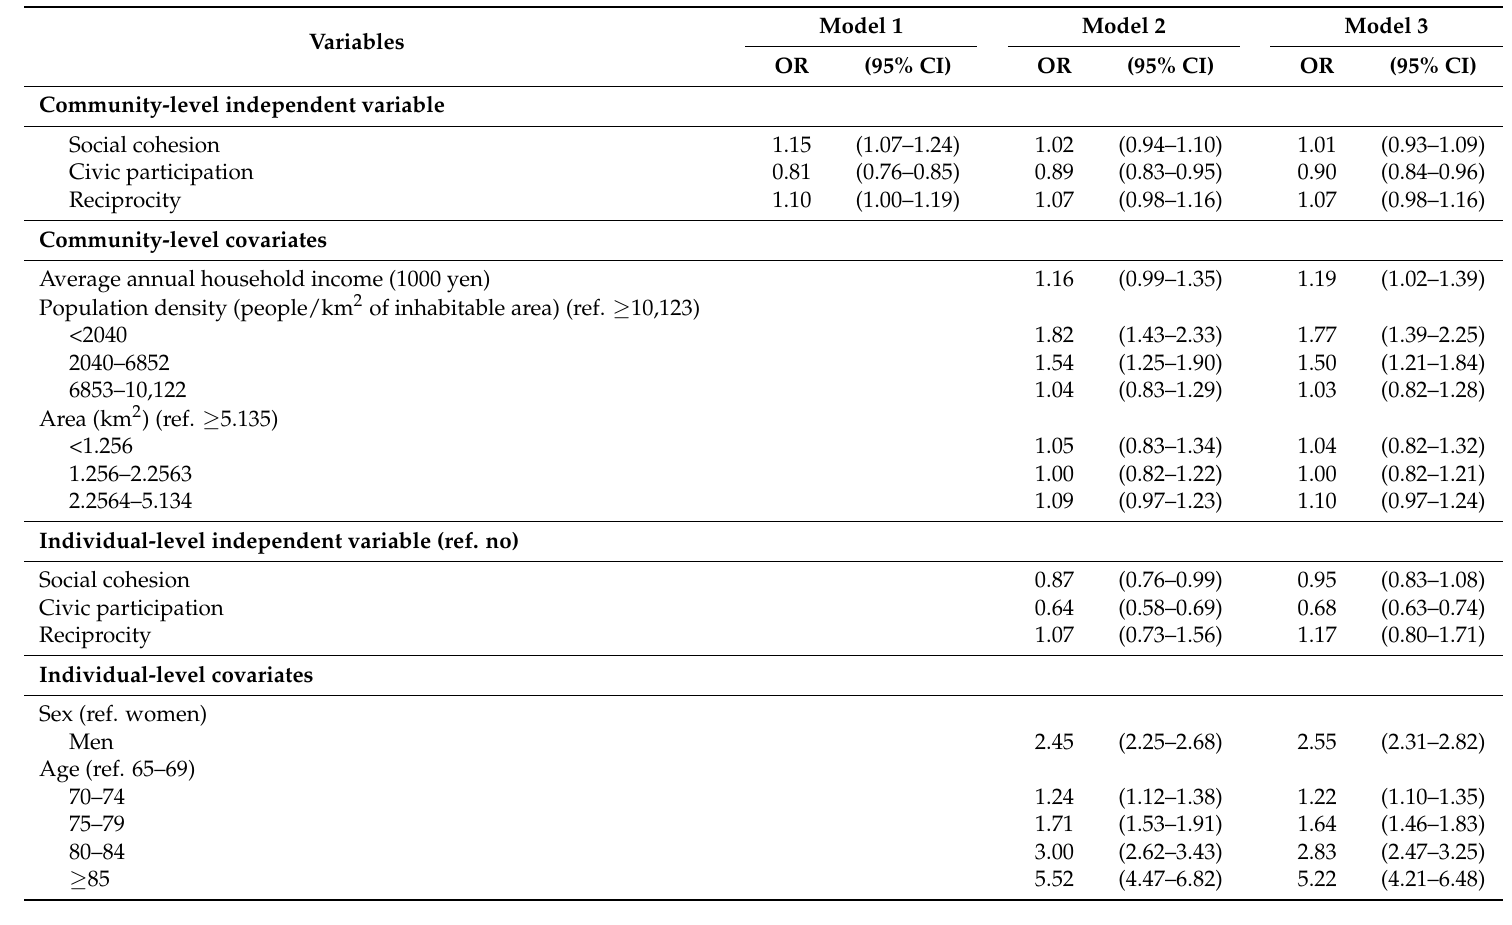
Table 4. Association of IADL disability with community- and individual-level variables determined by multilevel logistic-regression a